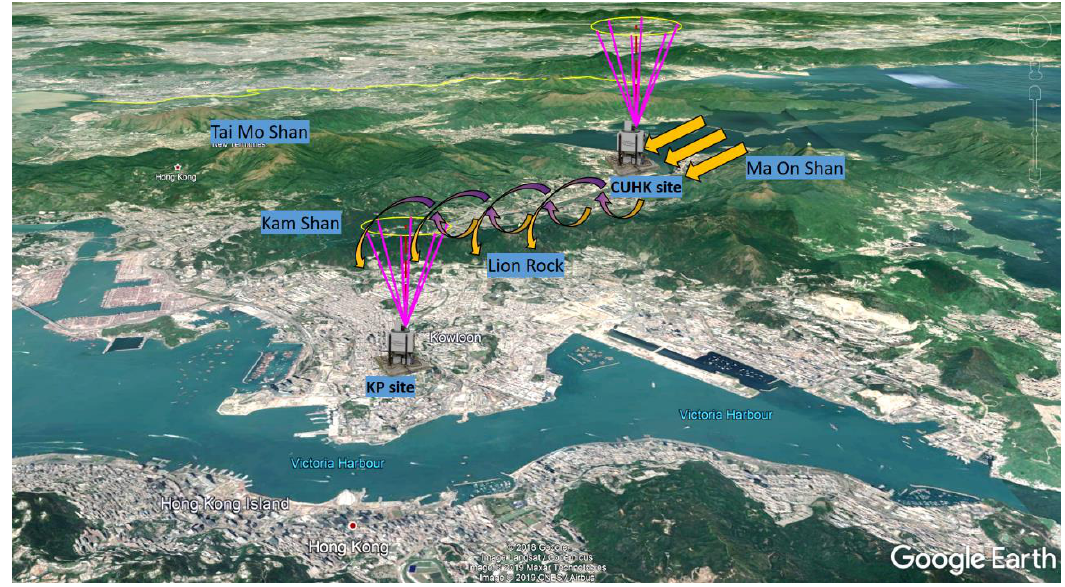
Figure 1. Locations of the two LiDAR sites (CUHK and KP), topography near the CUHK site, and schematic of the upslope and downslope winds. The arrows refer to wind direction. The arrow colors refer to altitude: orange: lower altitude; purple: higher altitude. This CUHK site is surrounded by mountains, including Ma On Shan (≈700 m), Lion Rock (≈500 m), Kam Shan (≈370 m), and Tai Mo Shan (≈957 m). The figure was built on a map obtained from Google Earth, earth.google.com/web/.